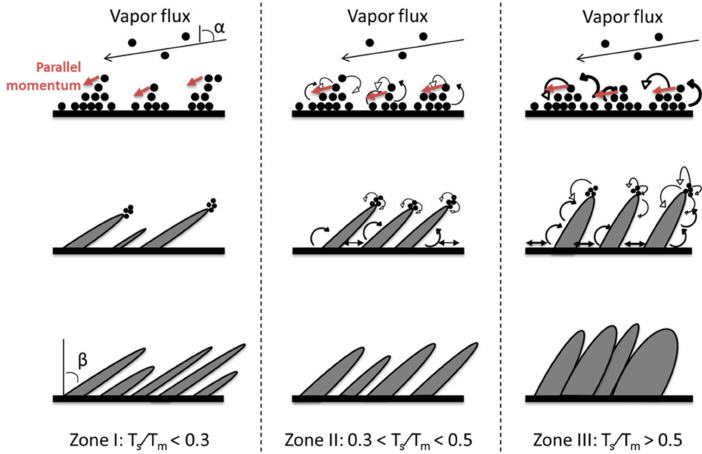
Figure 16. Growth models expected for oblique angle deposition at di ff erent substrate temperatures (reproduced from [50] with permission from Elsevier,